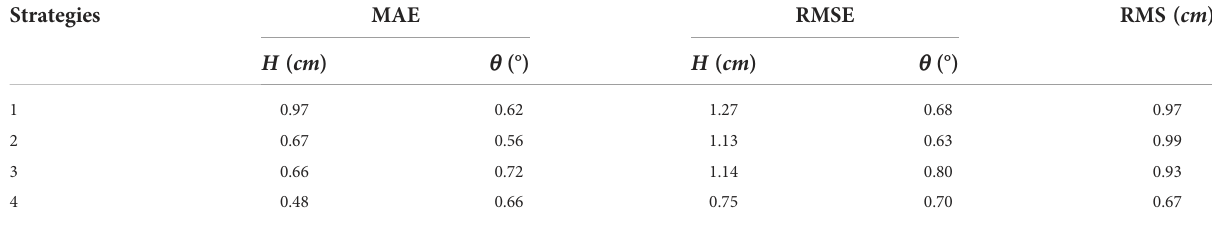
TABLE 1 Differences between SOs and re-estimated HCs for the four strategies. Strategies